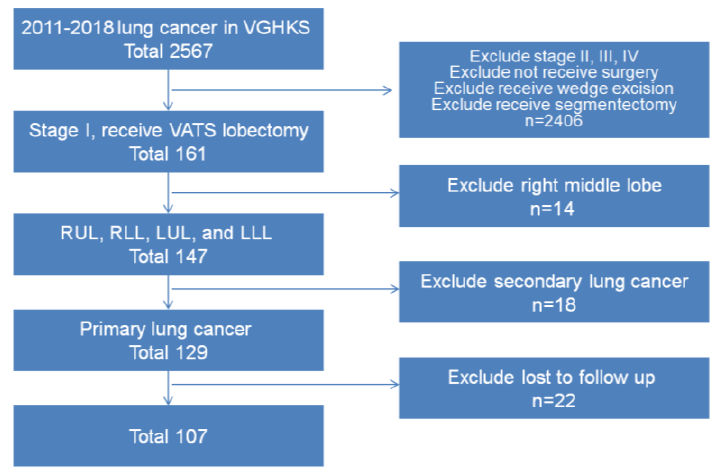
Figure 1. Patient selection. Inclusive and exclusive